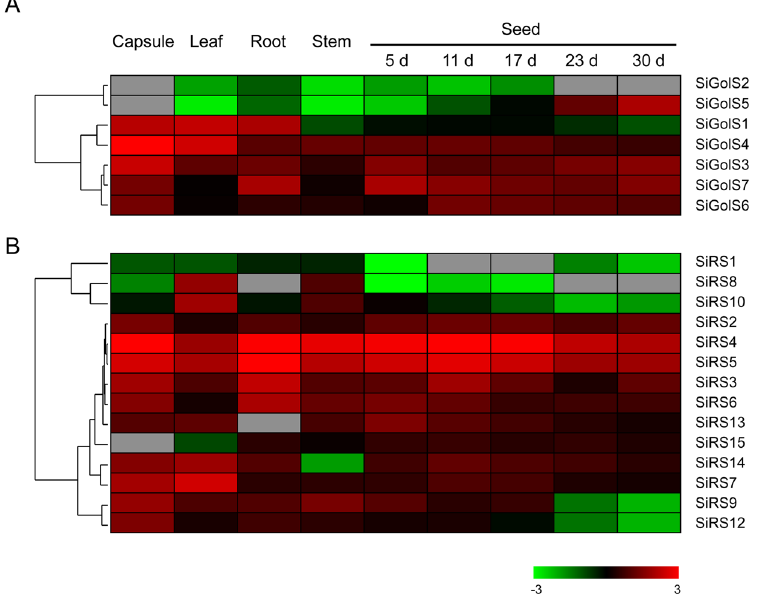
Figure 3. Expression profiles of the SiGolS and SiRS genes in different tissues. Transcriptome data downloaded from Sesame Functional Genomics Database (SesameFG, http://www.ncgr.ac.cn/SesameFG) was used to measure the expression level of SiGolS ( A ) and SiRS ( B ) genes in capsule, leaf, root, stem and seed at different stage of development. Heat maps were constructed by Cluster 3.0 based on the log 10 -transformed RPKM values for each gene. Gray box indicated the expression data is not available in this organ or time point. The color scale for expression values is